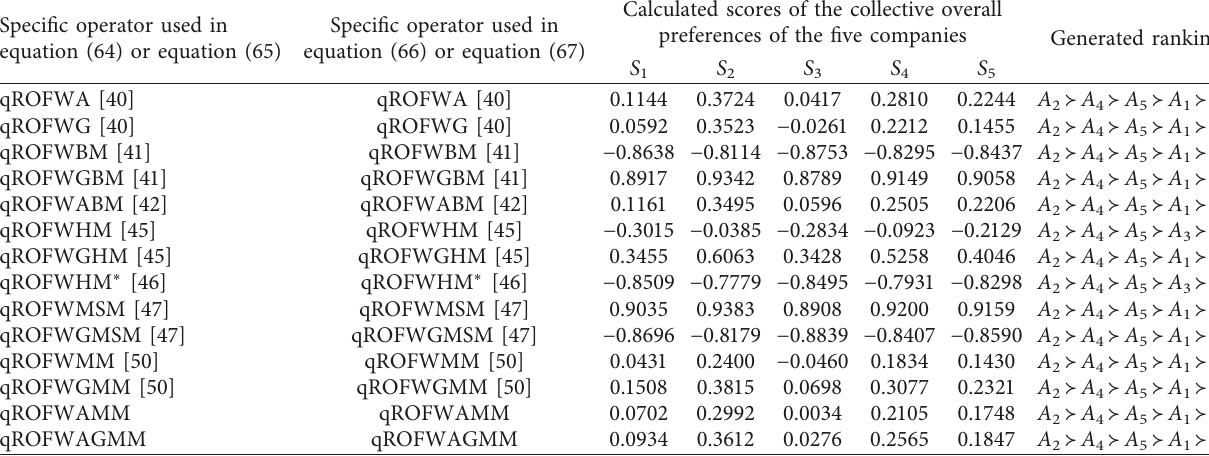
Table 6: The results of the quantitative comparison with the MCGDM methods based on aggregation operators of qROFNs. Notes: for easy comparison, all the methods used the same score function (see Definition 2). When comparing the method based on WABM, the most generalized q-rung orthopair fuzzy weighted Archimedean Hamacher Bonferroni mean (WAHBM) operator was selected. When com- paring the proposed method, the most generalized WAHMM and WAHGMM operators were selected. When adapting the fourteen groups of operators, q � 1 for all groups of operators; λ � 3 for the groups of WAHBMs, WAHMMs, and WAHGMMs. s � 1 ( a � 1) and t � 0 ( b � 0) for WBM and WAHBM (WHM and WHM ∗ ) in equation (64) and WGBM (WGHM) in equation (65); s � 1 ( a � 1) and t � 2 ( b � 2) for WBM and WAHBM (WHM and WHM ∗ ) in equation (66) and WGBM (WGHM) in equation (67); k � 1 ( Δ � ( δ 1 , δ 2 , δ 3 ) � (1, 0, 0)) for WMSM (WMM and WAHMM) in equation (64) and WGMSM (WGMM and WAHGMM) in equation (65); and k � 4 ( Δ � ( δ 1 , δ 2 , δ 3 ) � (1, 2, 3, 4)) for WMSM (WMM and WAHMM) in equation (66) and WGMSM (WGMM and WAHGMM) in equation